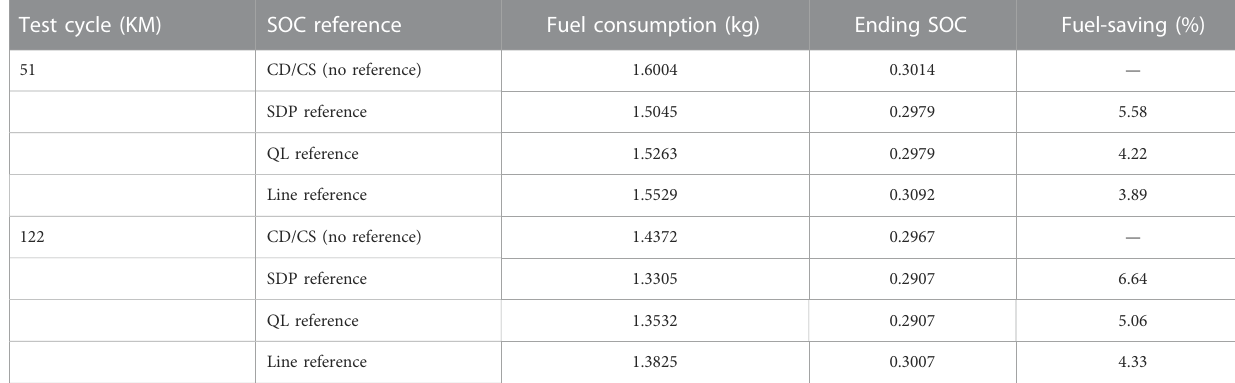
TABLE 6 Fuel consumption results under three different reference trajectories. Test cycle (KM)